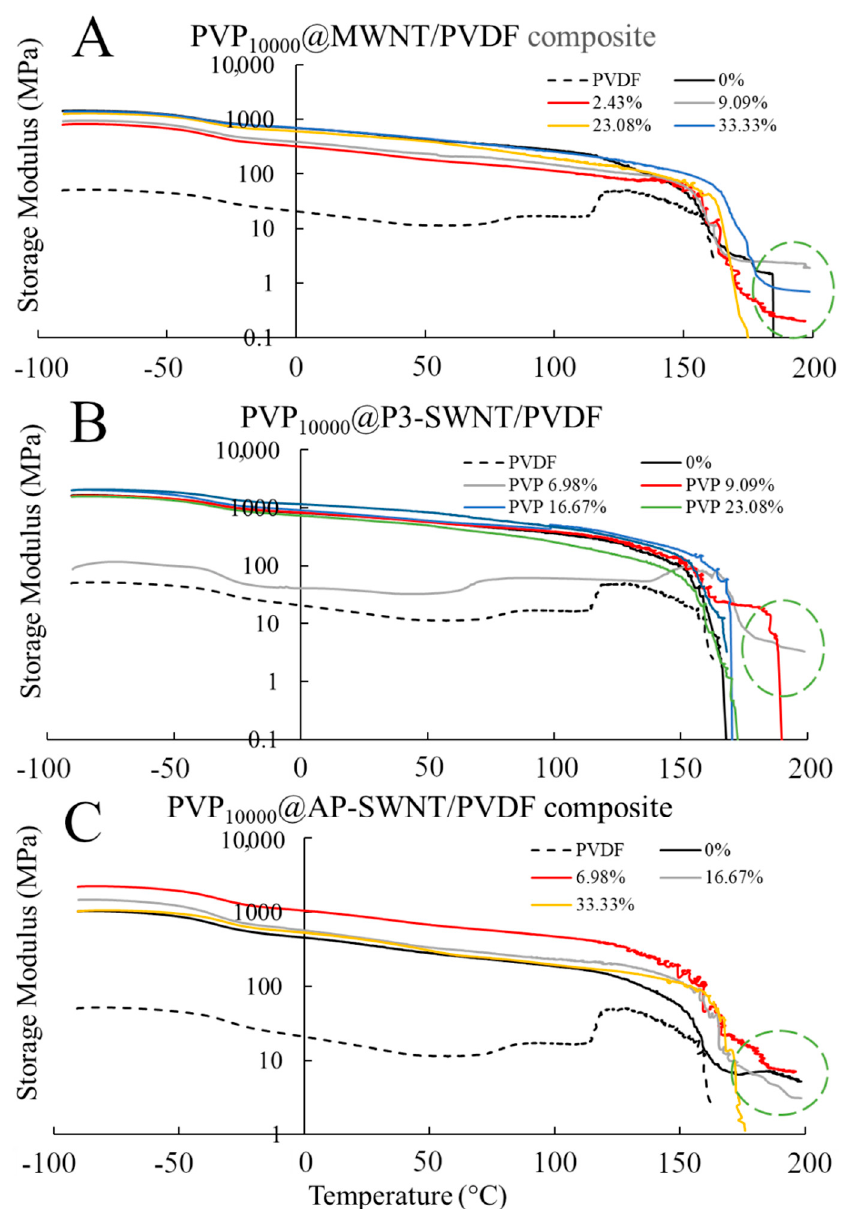
Figure 2. Storage Modulus of PVP 10000 functionalized MWNT ( A ); P3-SWNT ( B ); and AP-SWNT ( C ) in PVDF composite.